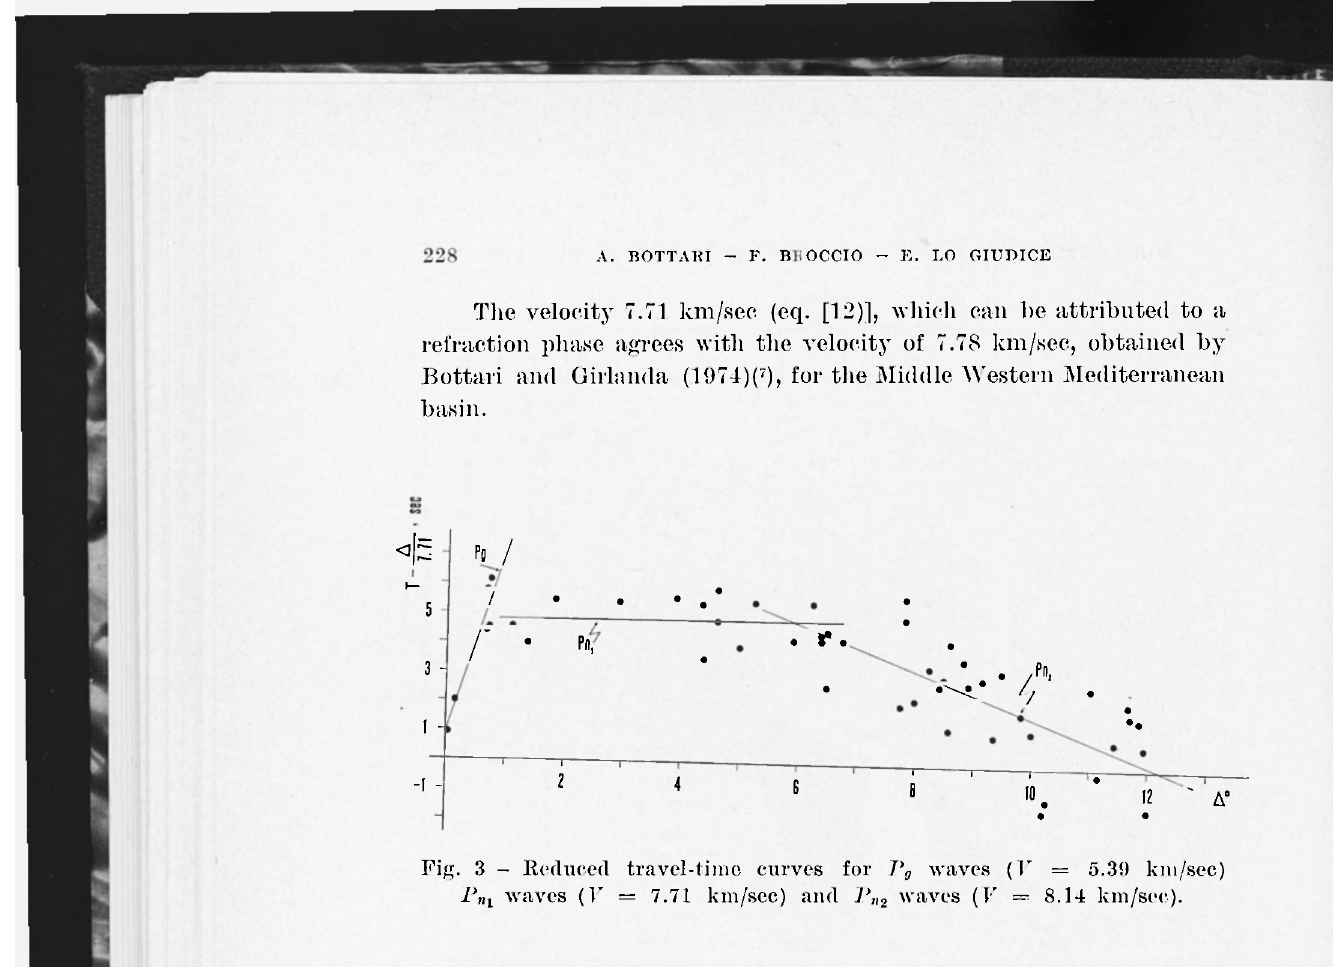
Fig. 3 - Reduced travel-time curves for I\ waves (T* = 5.39 km/sec) P ni waves (F = 7.71 km/sec) and P„ 2 waves ( V 8.14